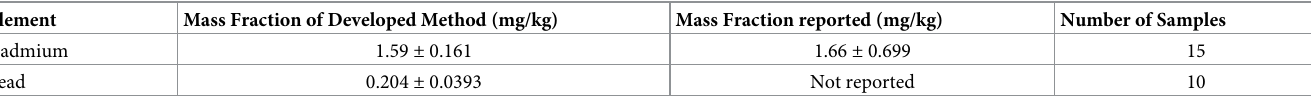
Table 6. Cadmium and lead concentrations measured in BCR 679 following the developed sample preparation method. Please note that only cadmium was certified. Element Mass Fraction of Developed Method